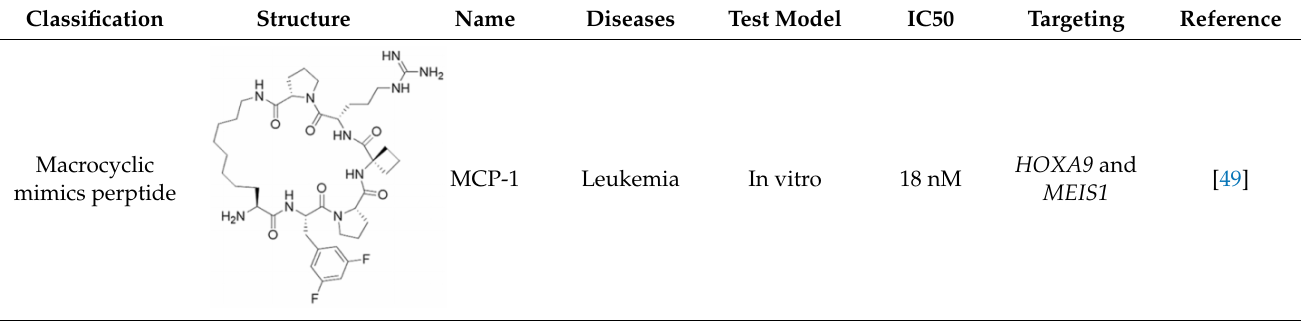
Table 3. Summary of Macrocyclic Mimics Peptide inhibitors tested against various